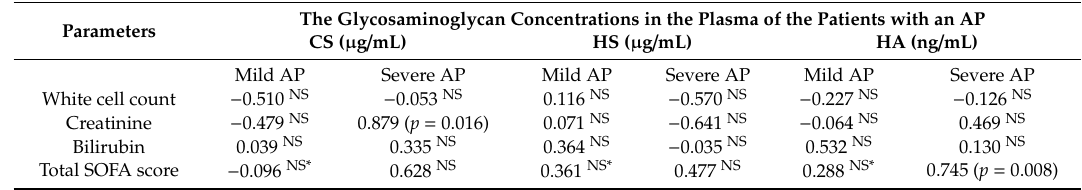
Table 2. Pearson’s coe ffi cients that describe the relationship between the plasma concentrations of glycosaminoglycans and the laboratory / clinical parameters in the patients with mild and severe acute pancreatitis (AP) at admission